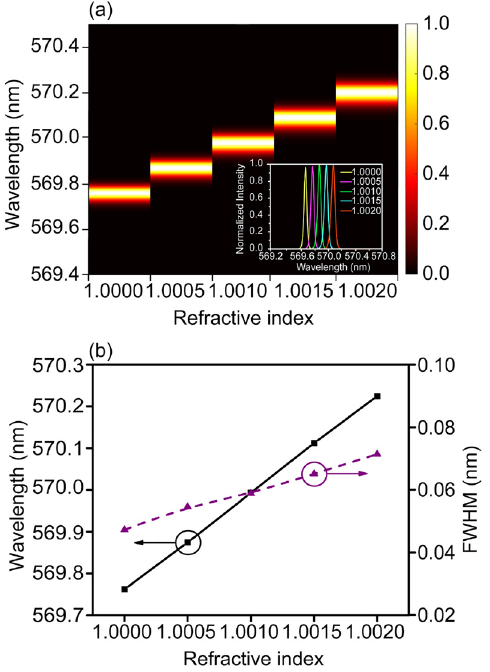
Figure 5: Sensing characterization. (a) Mapping of emission wavelength shift with the variation of environment refractive index, inset: full lasing spectra for different refractive indexes; (b) linear relationship between emission wave- length shift and environment refractive index (black curve), and the corresponding spectrum linewidth changing with refractive